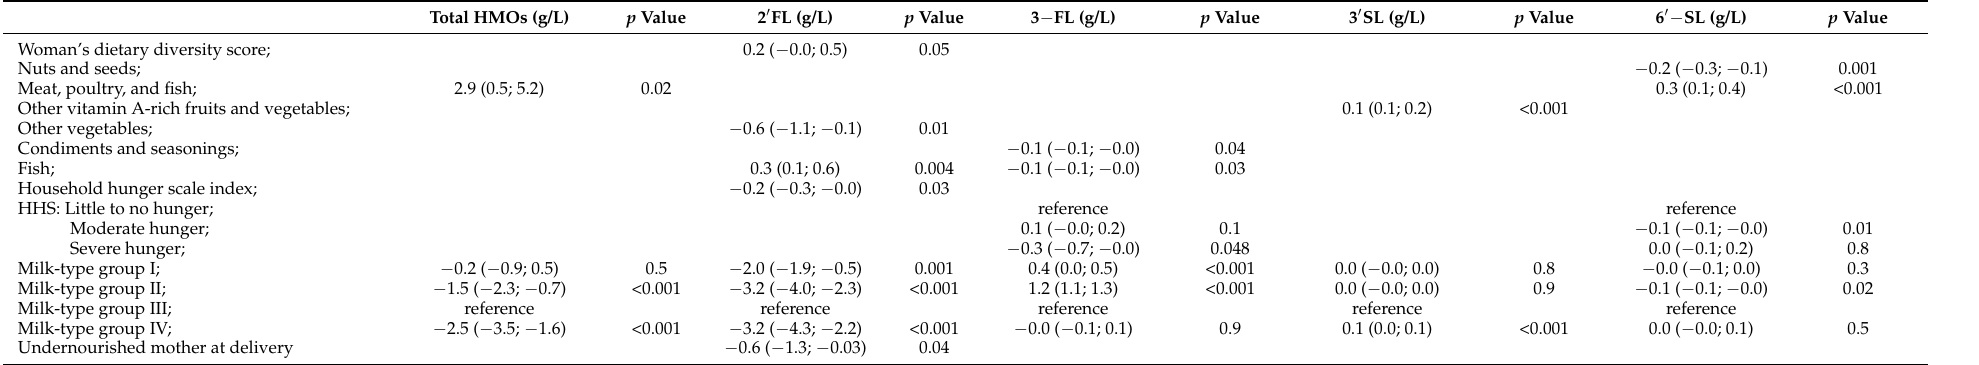
Table 2. Multilevel models of the dietary determinants of human milk oligosaccharide levels during the first 6 months of life (1).